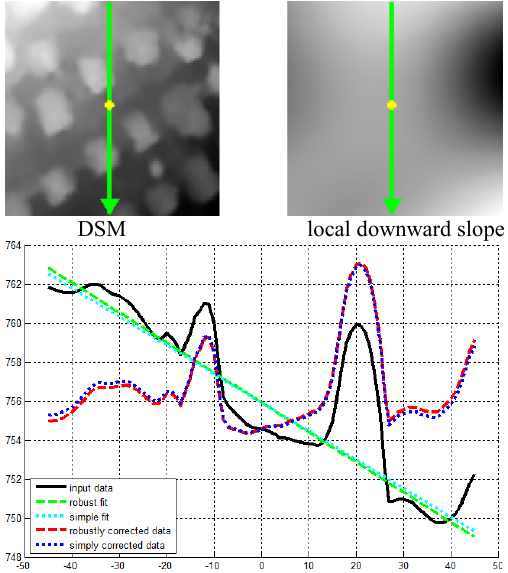
Figure 2. Comparison of robust terrain slope fit to the proposed simple fit.